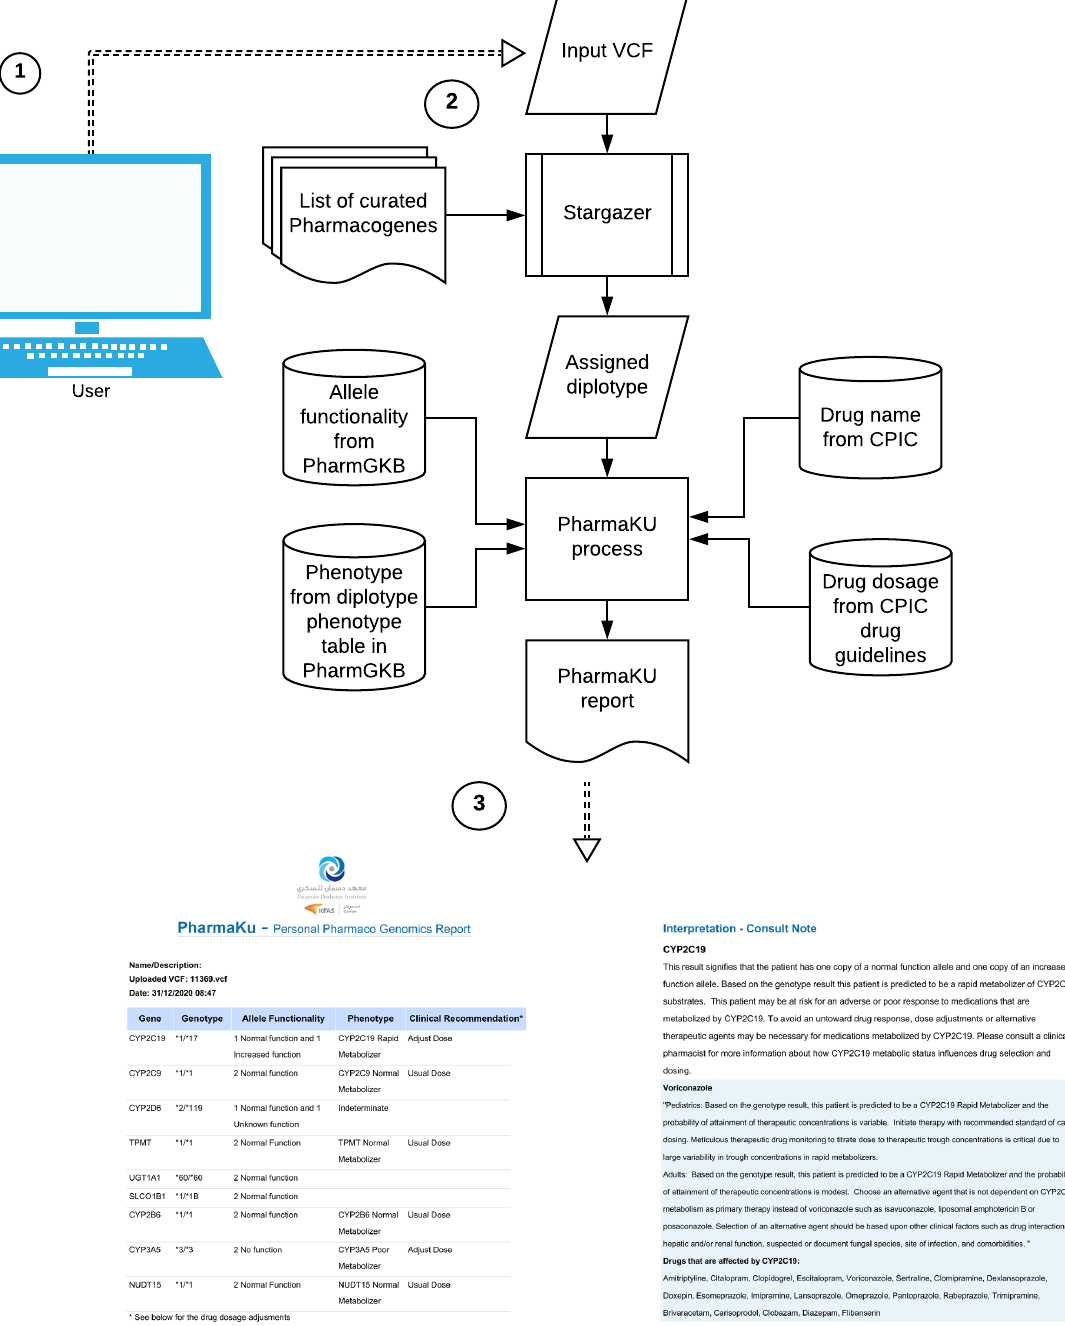
Figure 2. Working of the PharmaKU software: 1 (cid:13) Single sample WGS VCF file provided as user input through the web interface; 2 (cid:13) The software uses Stargazer to detect diplotypes in the nine pharmacogenes and assigns the corresponding allele functionality, phenotype, drug names and recommended dosage information; 3 (cid:13) Personalized pharmacogenomics report generated that is downloadable in PDF